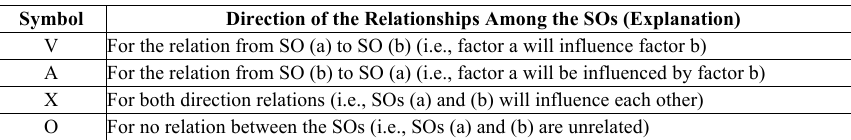
Table 2. Direction of the Relationships among